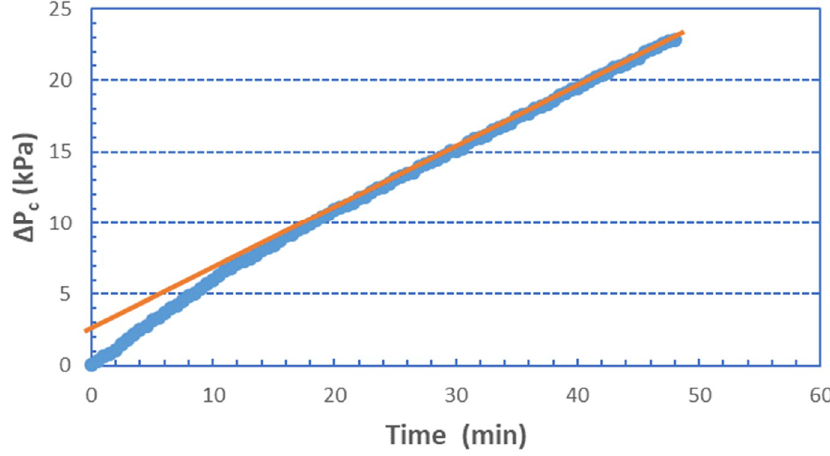
∆ P c across 100% BSA fouling layer. Permeate flux J = 34 L/m